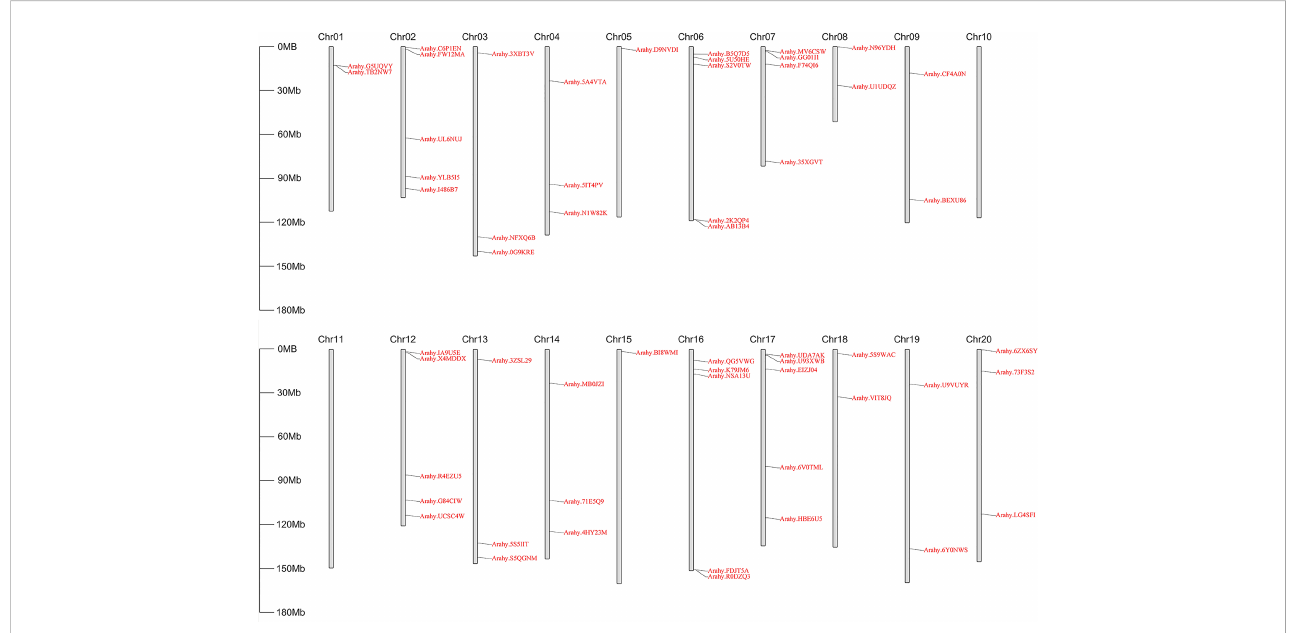
FIGURE 2 Physical location of AhGPATs genes on peanut chromosomes. The 56 predicted AhGPATs genes from cultivated peanut ( Arachis hypogaea ) were used to construct a physical location distribution map on chromosomes using TBtools software. Chromosome numbers are indicated on the top of each scaffold. Chromosome size is shown on the left vertical